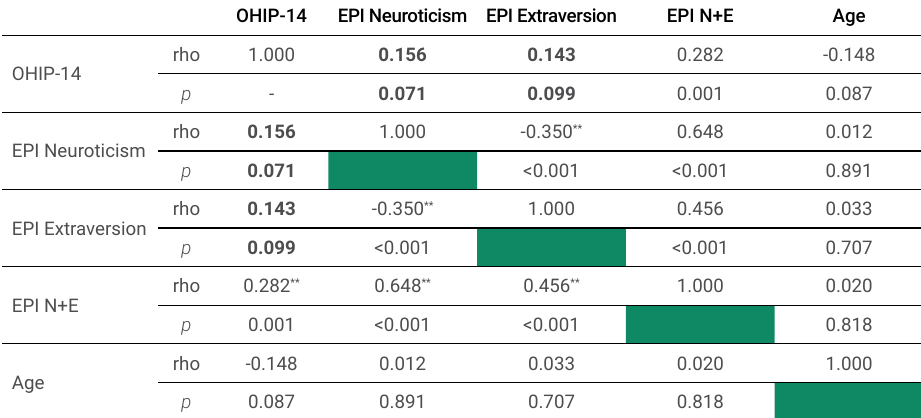
Table 1. Spearman’s rho between all scores and age